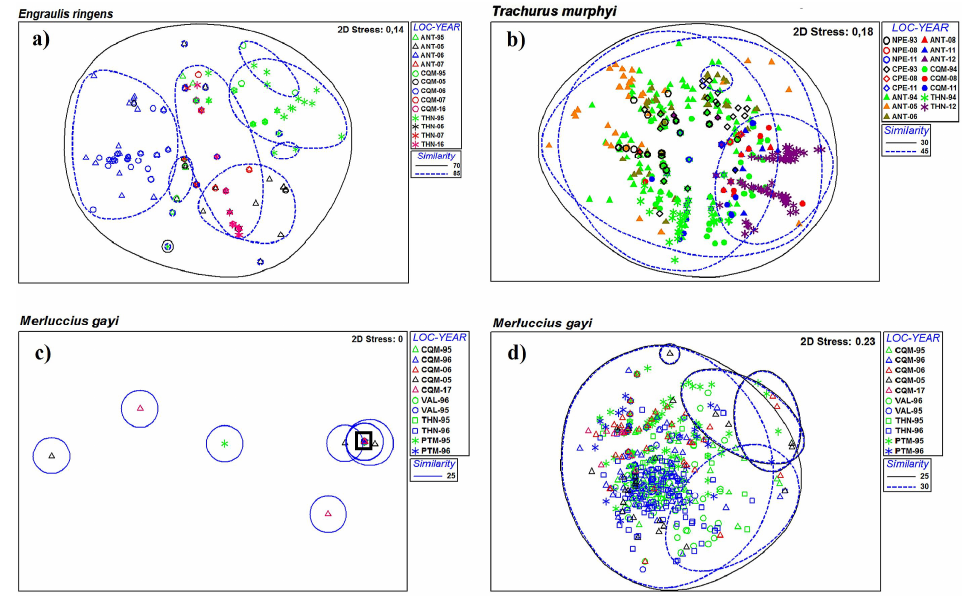
Figure 3. Non-metric multidimensional scaling (nMDS) of parasite infra-communities in three fish species in the southeastern Pacific Ocean: ( a ), Engraulis ringens ; ( b ), Trachurus murphyi ; ( c ), Merluccius gayi ; ( d ), subset (of the black square) of Merluccius gayi in ( c ). Circles represent similarity levels between samples of